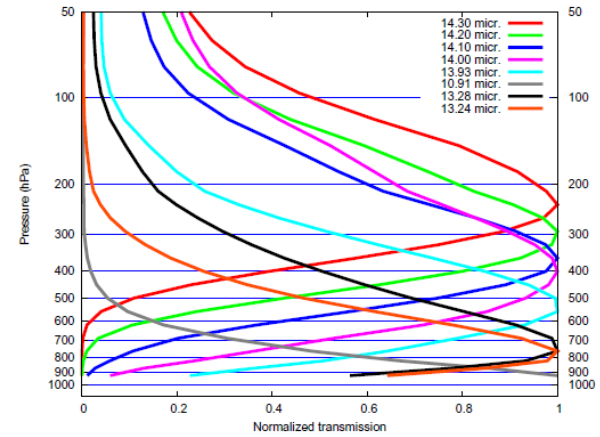
Figure 1: Weighting functions of eight AIRS channels, from near the centre towards the wing of the CO 2 Fig. 1. Weighting functions of eight AIRS channels, from near the absorption band around 15 μ m, used in the cloud property retrieval. centre towards the wing of the CO 2 absorption band around 15µm, used in the cloud property